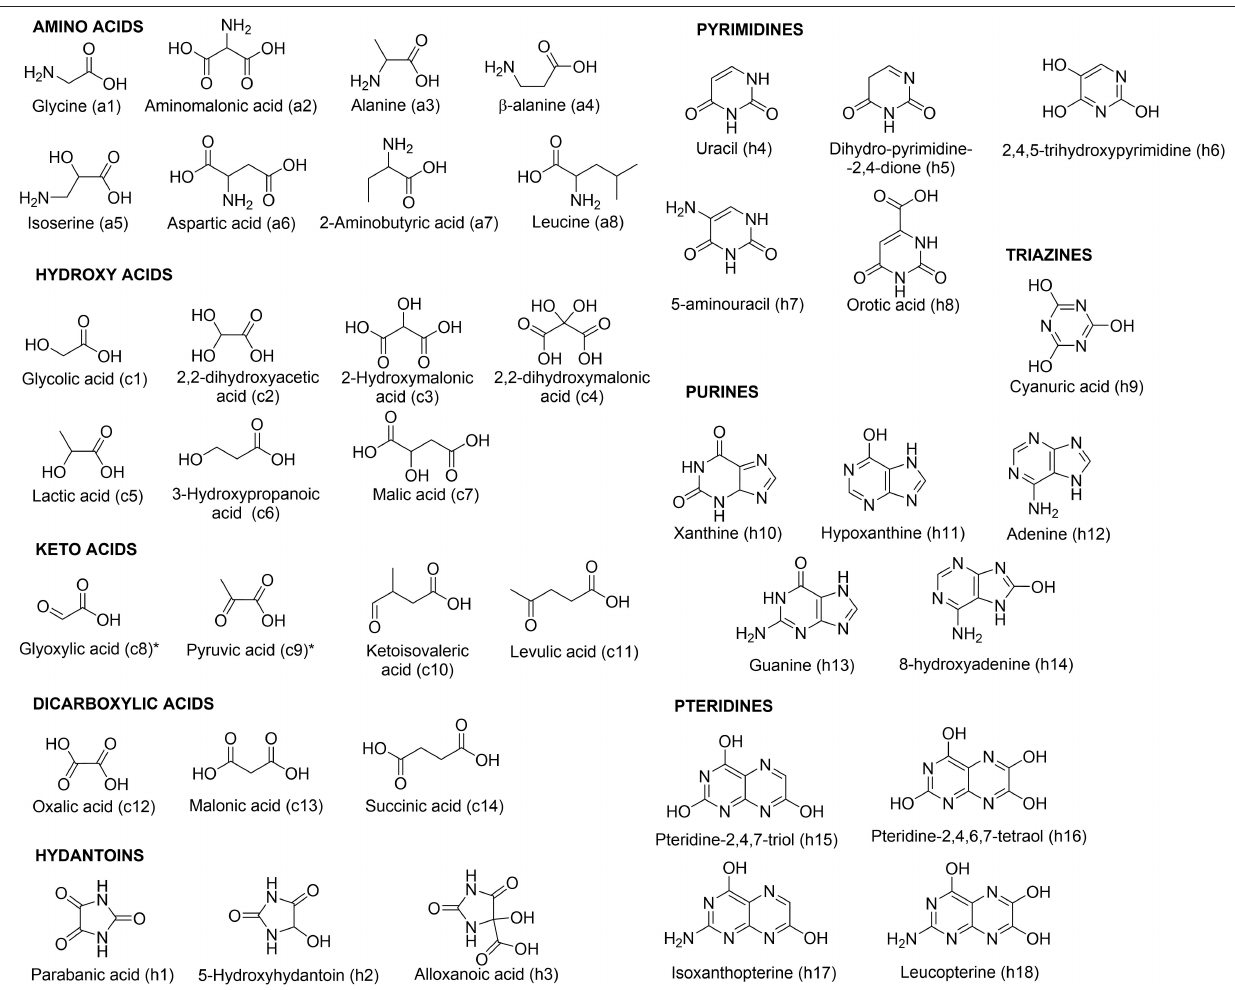
FIGURE 1 | Polar organic compounds identified as their TMS derivatives by GC-MS in insoluble and soluble NH 4 CN polymers, synthetized as detailed in Table 1 . *Glyoxylic acid and pyruvic acid were identified as their oxime-TMS derivatives. The formation of the corresponding oximes is explained in Marín-Yaseli et al. (2016). Some of the compounds represented can be in different tautomeric form. In the particular case of pteridines only the tautomer assigned to the TMS-derivative identified by GC-MS was represented ( Marín-Yaseli et al., 2016). For the rest of the analytes the tautomer form provided by ChemDraw Professional 15.0 is